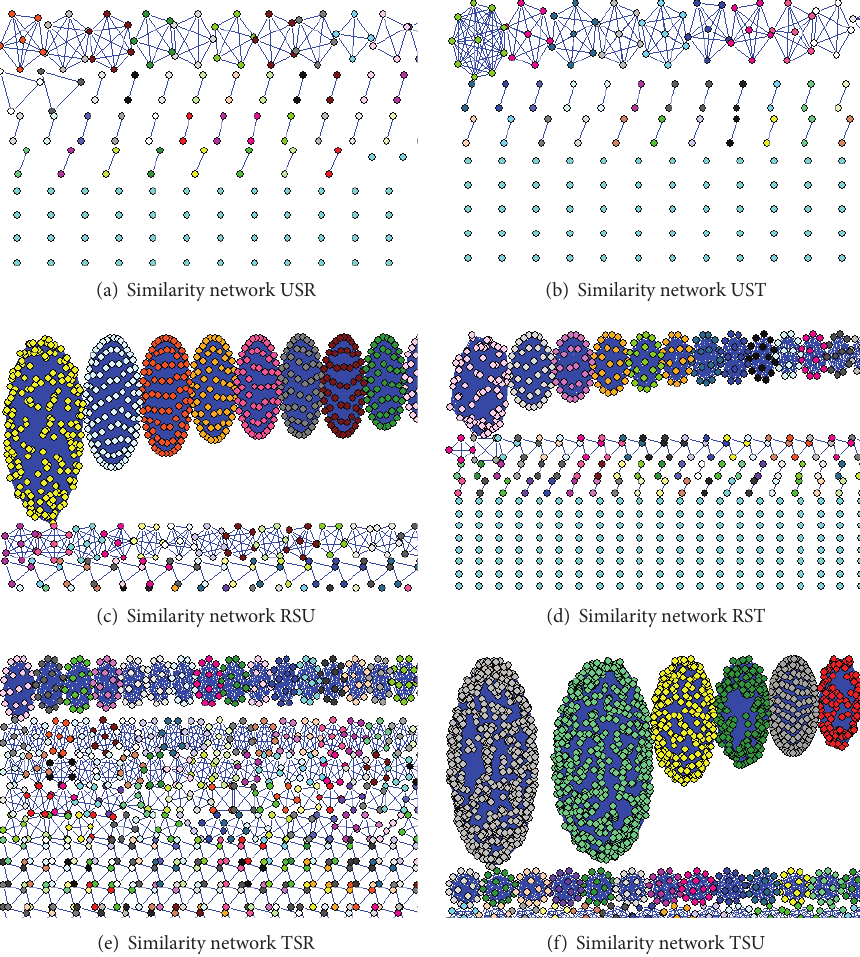
Figure 4: The PCN networks of six algorithms.